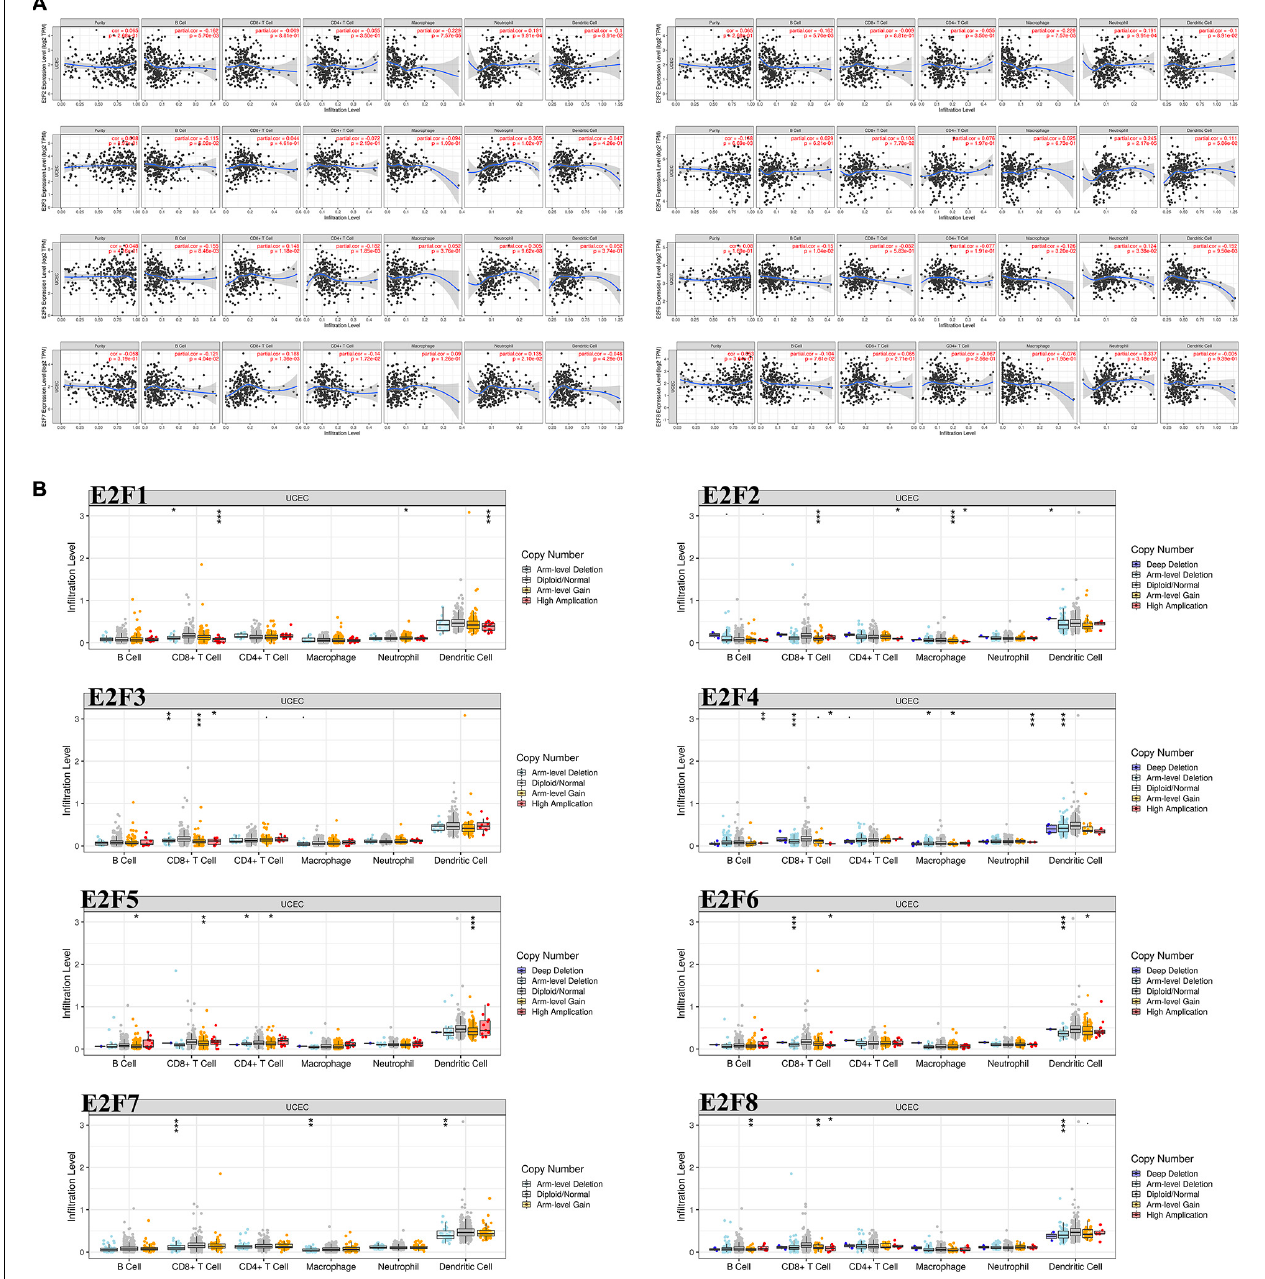
FIGURE 10 | The correlation between E2Fs and immune infiltration in UCEC. (A) The correlation between expression of E2Fs and the abundance of immune cells in UCEC. (B) The role of somatic copy number alterations in E2Fs and immune cell infiltration in UCEC. * P < 0.05, ** P < 0.01, *** P < 0.001.